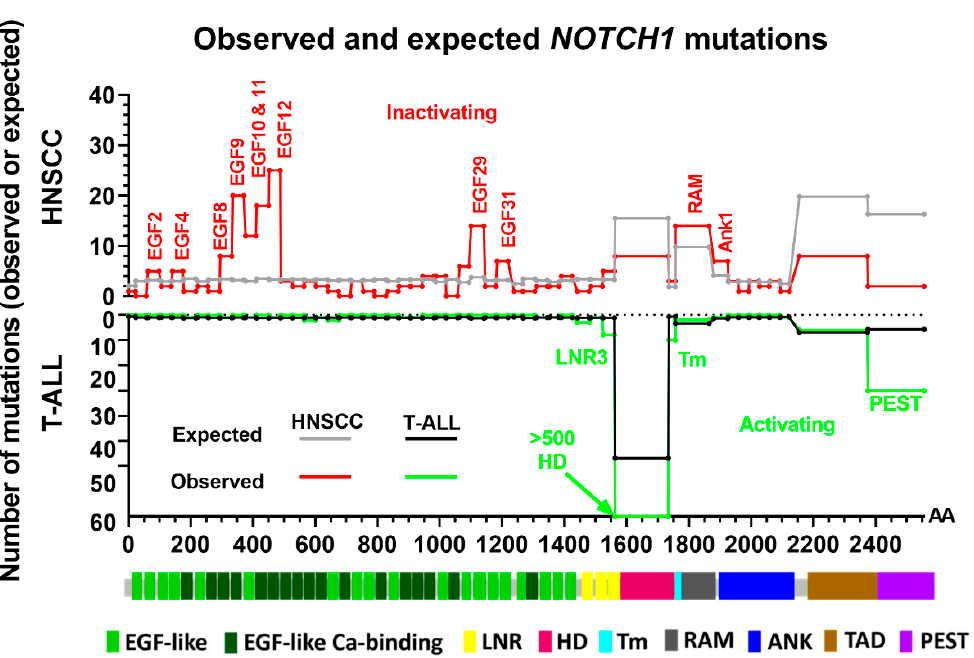
Figure 3. Domains enriched for NOTCH1 missense and in-frame mutations. Unique NOTCH1 missense and INDEL mutations (excluding truncations) from T-ALL and HNSCC within the COSMIC database and from the TCGA were filtered to include only those predicted to be impactful by PROVEAN or SIFT scores to obtain the total number of observed impactful mutations for either HNSCC ( n = 230) or T-ALL ( n = 843) used in calculations and the plot. The expected number of mutations for each domain was calculated by multiplying the probability for a mutation to occur in a domain (i.e., size of domain / total size of NOTCH1 protein) times the total number of impactful mutations. For T-ALL, the expected and observed mutations were calculated independently for the HD domain and domains outside this region to avoid skewing results.